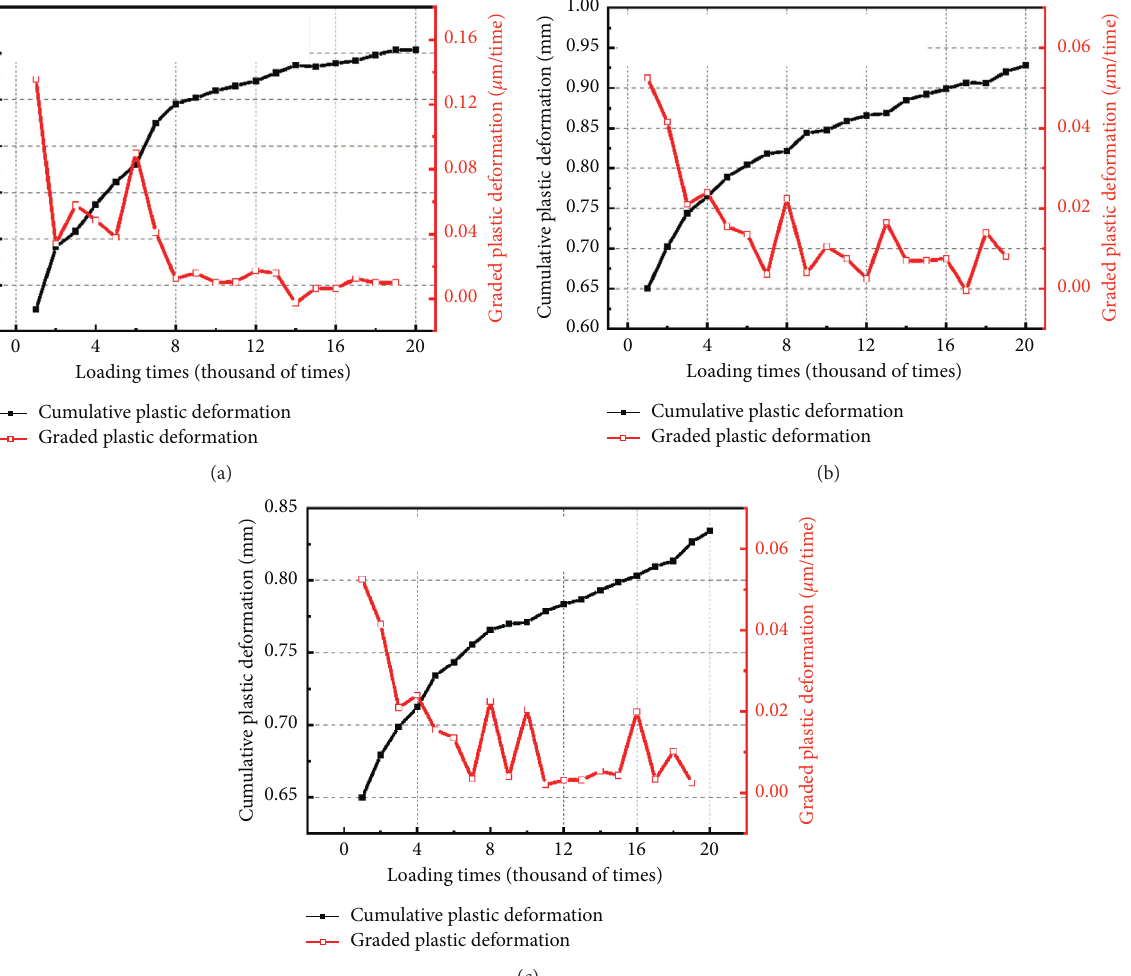
Figure 20: Cumulative plastic deformation and graded plastic deformation of each structural layer. (a) Cemented soil base. (b) Solidified soil base. (c) Fiber-reinforced soil